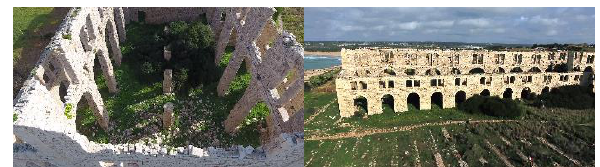
Figure 8. Frames from video examples: 45° oblique longitudinal (left) and from a strip on a single façade